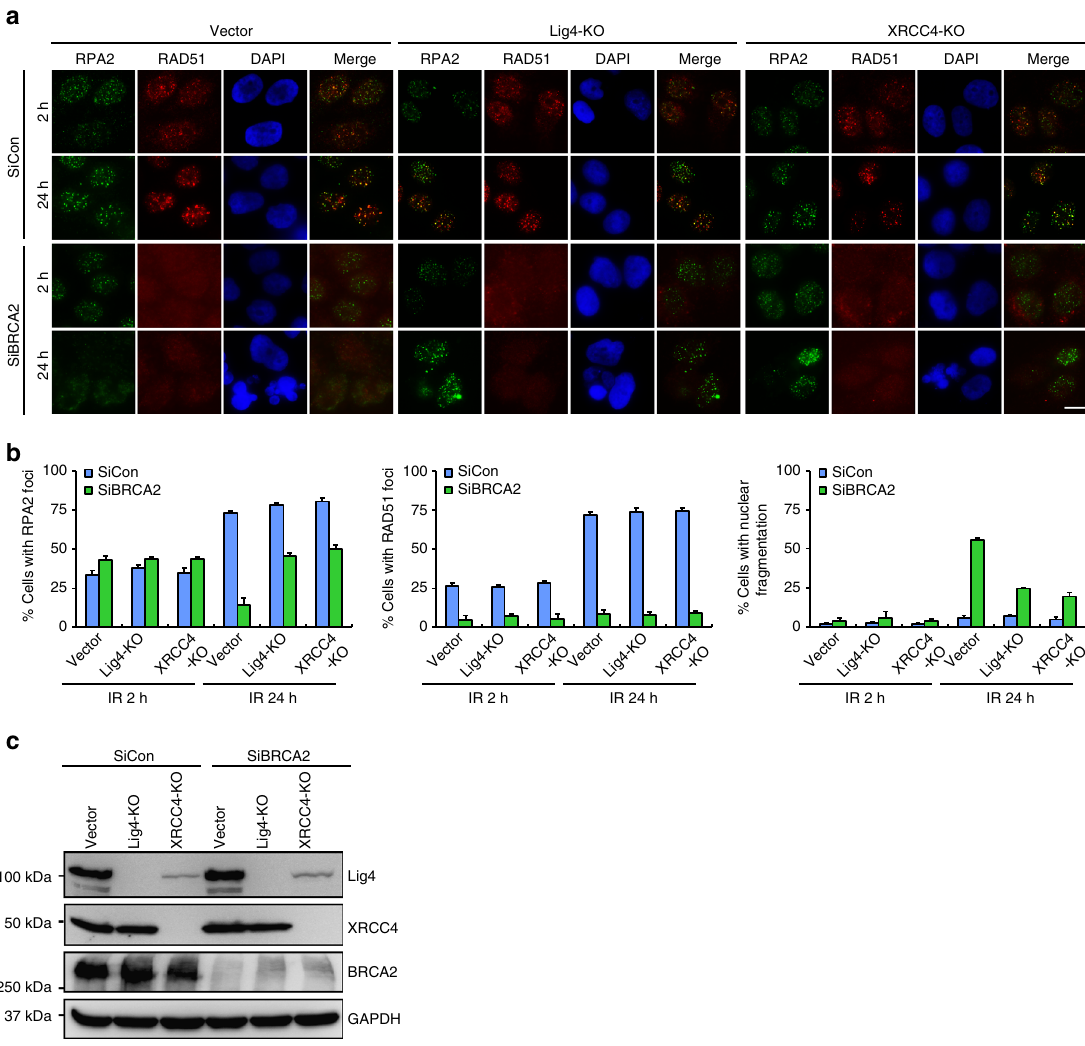
Fig. 3 C-NHEJ is partially responsible for gross genomic instability in BRCA2-depleted cells. a Wild-type, Lig4-, or XRCC4-de fi cient HeLa cells were transfected with control siRNA or siRNA against BRCA2. Forty-eight hours post transfection, cells were exposed to 10 Gy IR and then allowed to recover for 2 or 24 h before being processed for immuno fl uorescence using antibodies against RPA2 and RAD51. Representative RPA2/RAD51 foci and DAPI-stained nuclei are shown. b Quanti fi cation of RPA2/RAD51 foci and nuclear fragmentation. Data represent mean ± SEM of three independent experiments. Over 100 cells were counted in each experiment. c Knockdown/knockout ef fi ciency was con fi rmed by western blotting. Scale bar, 10 μ